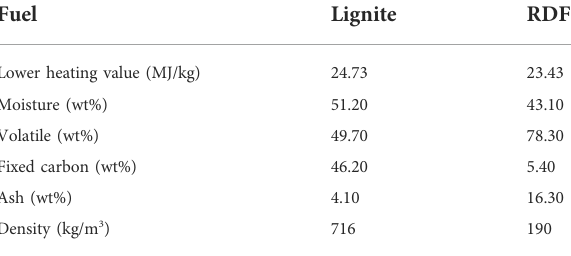
TABLE 2 The properties of the solid